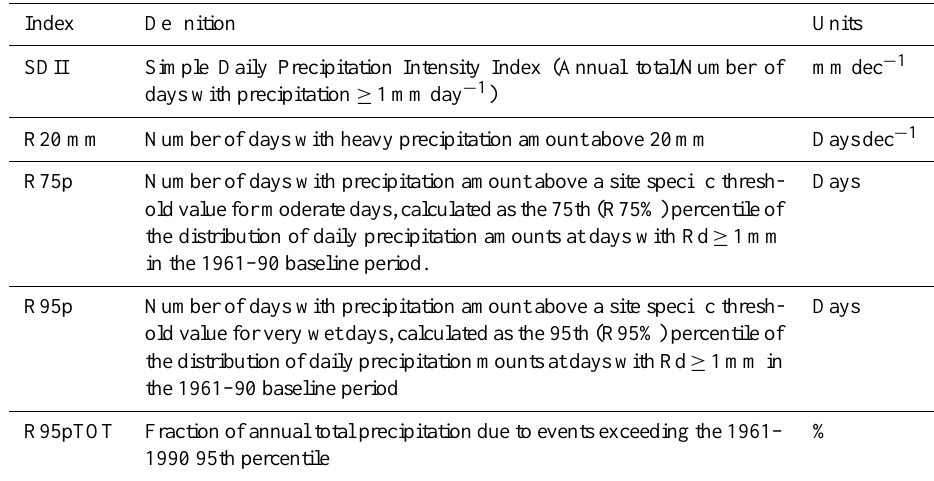
Table 1. Definitions and abbreviations of the ETCCDI indices of precipitation extremes used in this study.